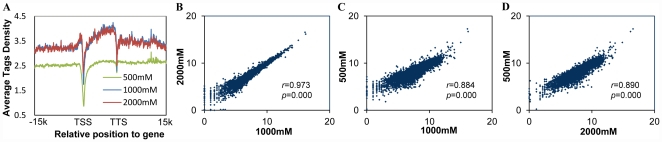
Correlation of tags density of different salt concentrations.A. A plot of average tags density vs a known gene (RefSeq HG18) for MBD-seq data in MCF-7 cell for three salt concentrations, 500 mM, 1000 mM and 2000 mM. The results showed a lower methylation levels occurs in the transcription start sites (TSS) and the transcription termination sites (TTS). Gene body and up down 15 kb region was plotted in this figure. The gene body region was evenly divided into 200 bins and 15 k bp up down gene body region was divided into 50 bp bins. Log tags count correlation analysis showed a higher correlation for 1000 mM vs 2000 mM (B, r = 0.973, p = 0.000) than 500 mM vs 1000 mM (C, r = 0.884, p = 0.000) and 500 mM vs 2000 mM (D, r = 0.890, p = 0.000).